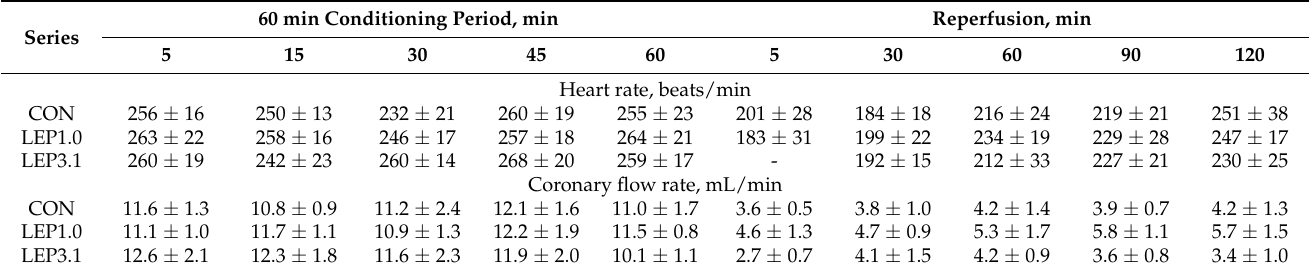
CON, control; LEP1.0, leptin 1.0 nM; LEP3.1, leptin 3.1 nM. Data are presented as mean ± standard deviation. 2.4. Myocardial Infarct Size There were no differences in myocardial infarct size between the CON and LEP3.1 groups (69 ± 7% and 71 ± 9%, respectively; p = 0.947). However, the addition of 1.0 nM leptin to the standard perfusion solution led to a significant reduction in infarct size (24 ± 3%; p < 0.001 vs. the CON and LEP3.1 groups; Figure 4).